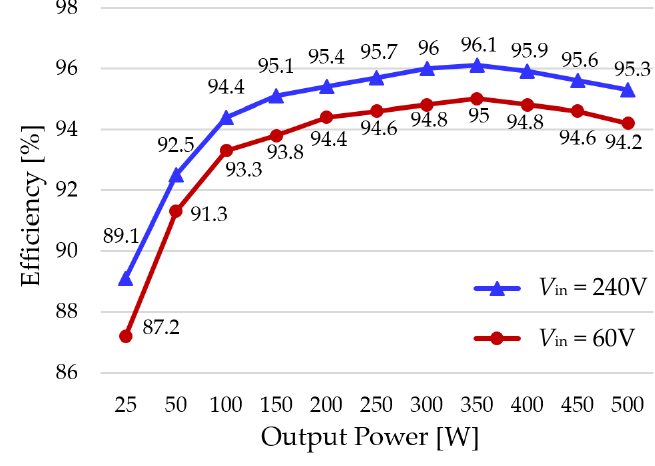
Figure 10. Efficiency measurement with V in = 60 V and V in = 240 V. Table 4. Parameters for power loss analysis.